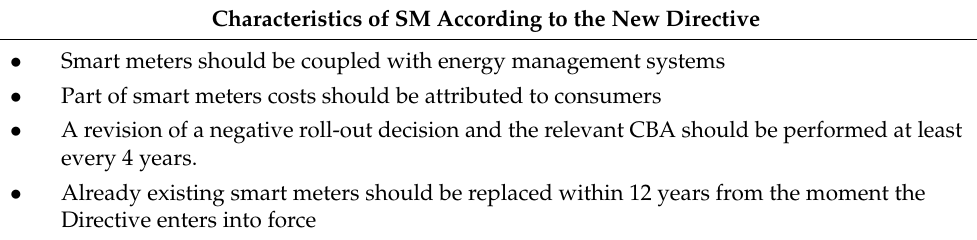
Table 3. Summary of main provisions on SM systems introduced by the Clean Energy Package.